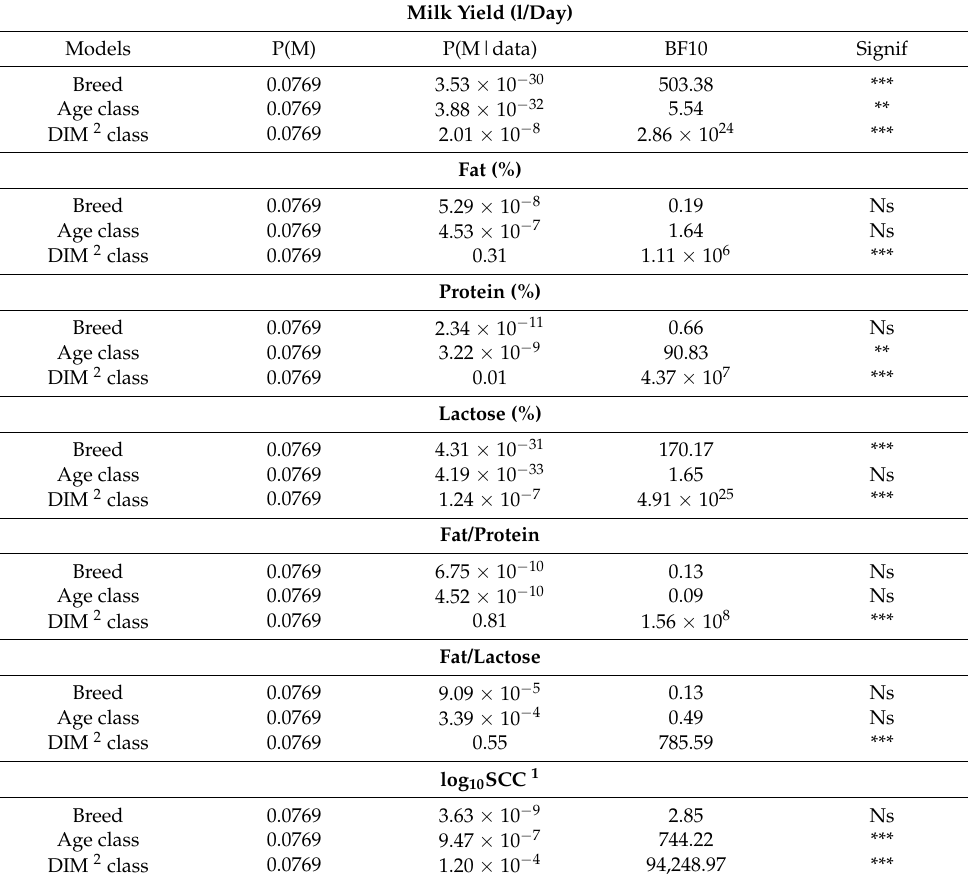
Table 4. Bayesian ANOVA results for milk variables. Significance symbols were derived from the BF10 values as reported in the text. The different asterisks indicate different levels of statistical significance: very strong (**), decisive (***).